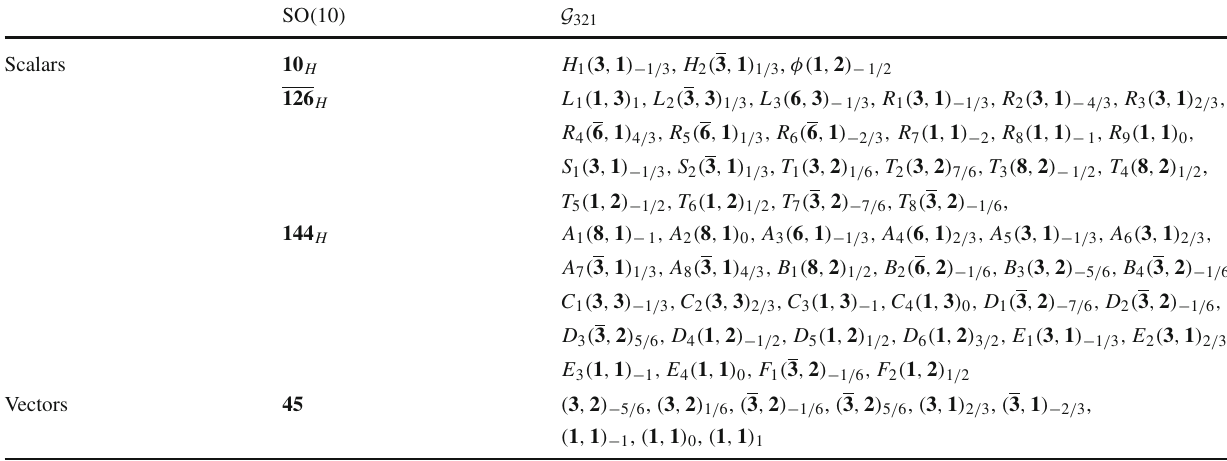
Table 3 Scalar and vector fields that have masses around M GUT in the G 321 model